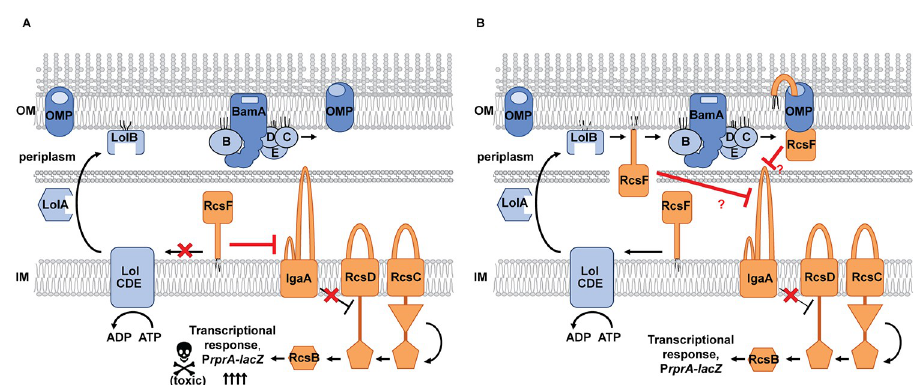
Fig 1. The Rcs stress response pathway. The IM hybrid histidine protein kinase RcsC and the phosphotransferase protein RcsD control the activity of the cytoplasmic DNA-binding response regulator RcsB via phosphorylation. IgaA is an essential negative regulator of the stress response. RcsF is a sensory OM lipoprotein that alleviates IgaA inhibition of the phosphorelay in response to stress. (A) Defects in lipoprotein lipid modification, signal sequence processing or export by the Lol pathway cause RcsF retention at the IM, where it constitutively interacts with IgaA causing toxic overactivation of the system. (B) Under normal conditions, RcsF is exported to the OM and assembled in a complex with OMPs. How the RcsF/OMP complex signals to IgaA and whether RcsF retention in the inner leaflet of the OM can constitutively activate the system was not resolved before the present study.